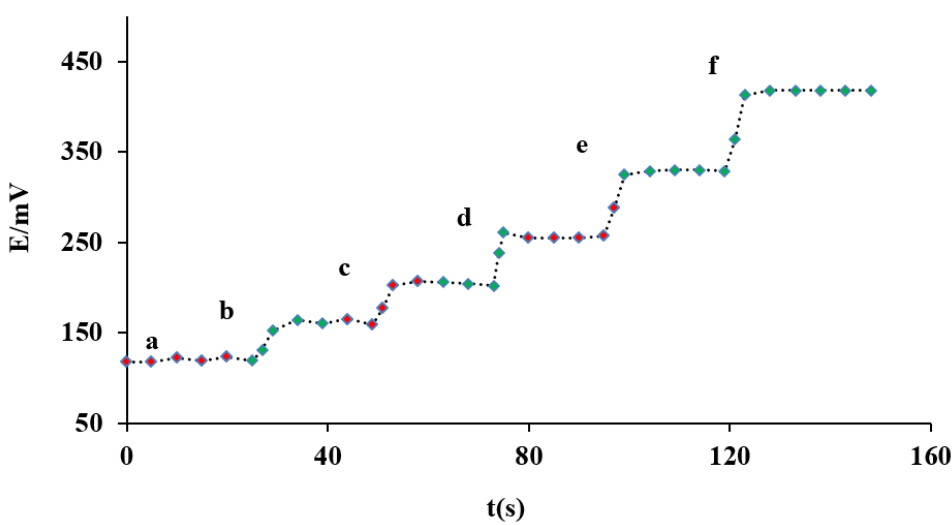
Figure 8. The relation of response time with Hg 2+ –SE potential at different concentrations of analyte and 298K: The curves of a, b, c, d, e, and f shows this relation at the Hg 2+ concentrations of 1.06 × 10 – 7 , 1.06 × 10 – 6 , 1.06 × 10 – 5 , 1.0 × 10 – 4 , 1.0 × 10 – 3 and 1.0 × 10 – 2 molL –1 , respectively.